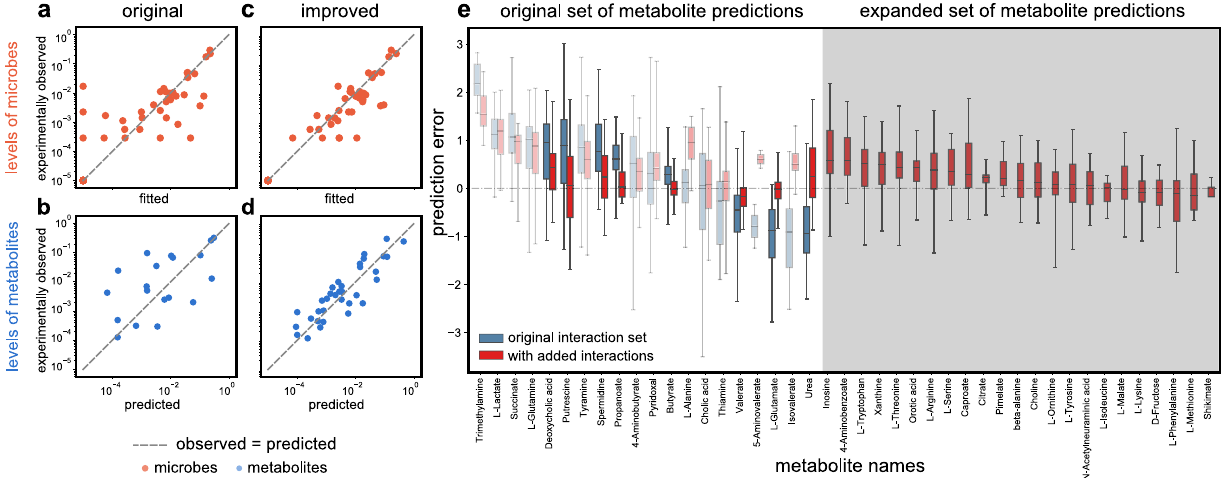
Fig. 4 The effects of GutCP ’ s predicted interactions on the gut microbiome and metabolome. a – d Each panel compares the levels of microbial species ( a and c ; blue) or metabolites ( b and d ; orange) predicted by our ecological consumer-resource model ( x axis) with the experimentally measured levels ( y axis); the closer a point is to the marked line (indicating an exactly correct prediction), the better our predictive power. The Pearson correlation coef fi cients for panels ( a ) through ( d ) are as follows: ( a ) correlation 0.88, P < 10 − 6 , ( b ) 0.75, P < 10 − 3 , ( c ) 0.88, P < 10 − 6 , and ( d ) 0.77, P < 10 − 6 . All P values are estimated using the two-sided t test. The predictions using the original, known-set cross-feeding interactions (production and consumption links) are on the left, and using the additional cross-feeding interactions predicted by GutCP are on the right. e Box plot showing the improvement in prediction error of each metabolite in the fecal metabolome ( n = 41 independent samples). In all boxplots, the middle line is the median, the lower and upper hinges correspond to the fi rst and third quartiles, the upper whisker ranges from the hinge to the value 1.5 × IQR (where IQR is the interquartile range) above the hinge and the lower whisker extends from the hinge to the value 1.5 × IQR below the hinge, while all data points failing beyond the range of whiskers are plotted individually. Predictions errors using the original cross-feeding network are in blue, and those with added interactions predicted by GutCP are in red. Central bars indicate median, boxes and whiskers indicate quartiles. Metabolites for which GutCP improved predictions highly are shown in solid bold colors for illustration; those with faded colors represent modest improvements. The shaded gray part of the plot shows new metabolites whose levels GutCP helped predict, but the original cross-feeding network could